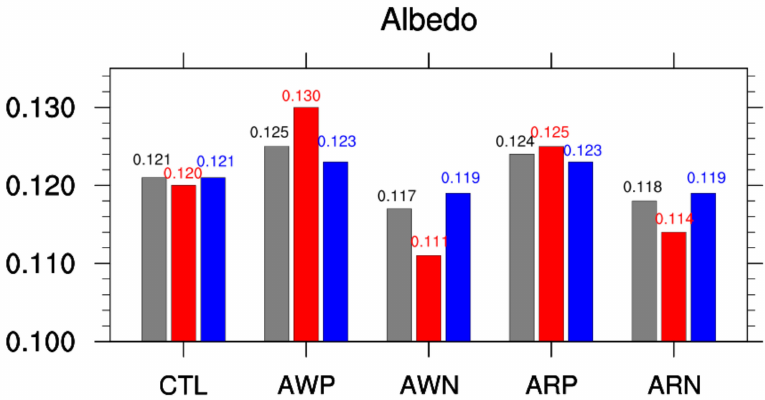
Figure 6. Mean albedo averaged at total (gray), urban (urban fraction ≥ 0.3, red), and suburban points (urban fraction < 0.3,